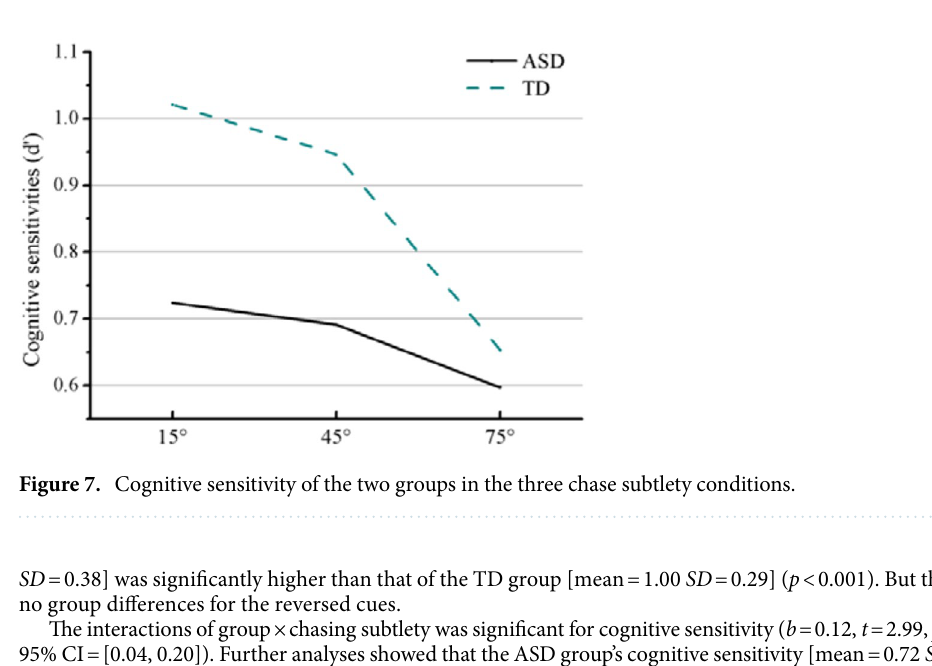
Figure 6. Stray-looking rate of the two groups for the three types of gaze cues.